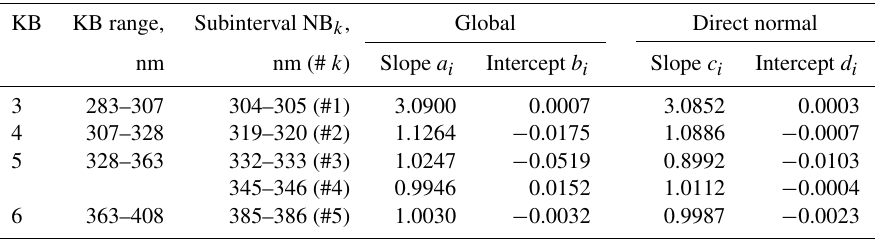
Table 3. KB covering the UV band and selected subintervals NB k ; slopes and intercepts of the affine functions between the clearness indices in KB and subintervals NB k .